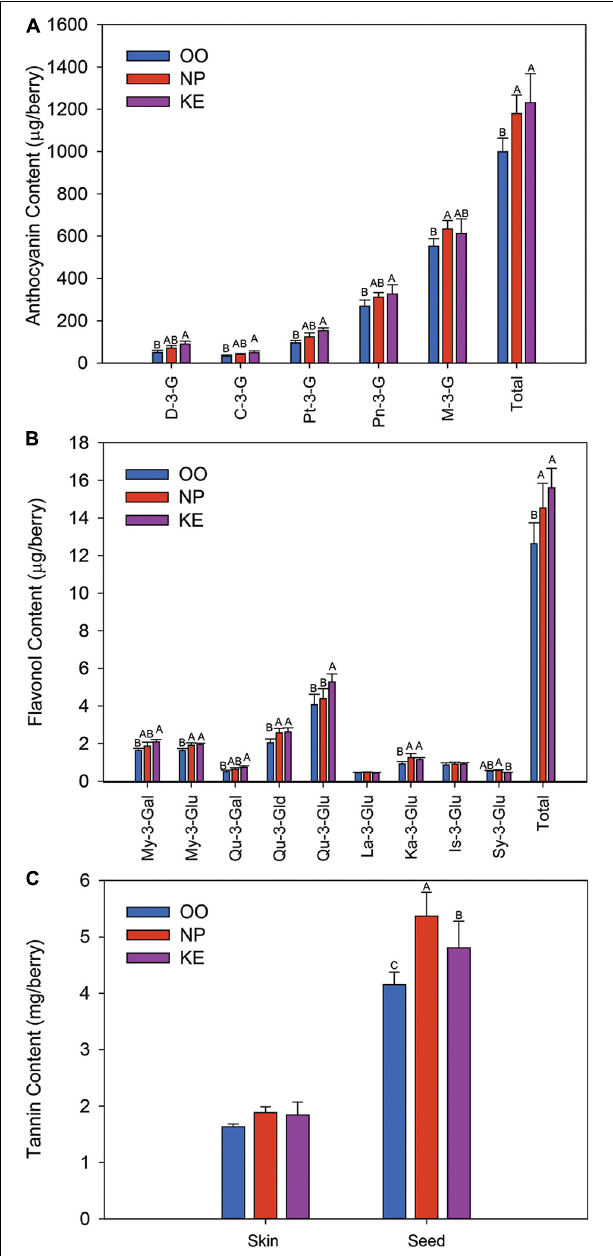
FIGURE 6 | Anthocyanin (A) , flavonol (B) , and tannin (C) content (amount per berry) of Pinot Noir grapes from three sub-regions of the OV (OO, blue; NP, red; and KE, purple). D-3-G, delphinidin-3-glucoside; C-3-G, cyanidin-3-glucoside; Pt-3-G, petunidin-3-glucoside; Pn-3-G, peonidin-3-glucoside; M-3-G, malvidin-3-glucoside for anthocyanins (A) ; and My-3-Gal, myricetin-3-galactoside; My-3-Glu, myricetin-3-glucoside; Qu-3-Gal, quercetin-3-galactoside; Qu-3-Gld, quercetin-3-glucuronide; Qu-3-Glu, quercetin-3-glucoside; La-3-Glu, laricitrin-3-glucoside; Ka-3-Glu, kaempferol-3-glucoside; Is-3-Glu, isorahamnetin-3-glucoside; Sy-3-Glu, syringetin-3-glucoside for flavonols (B) . Error bars indicate the standard error within each sub-region. An ANOVA was performed to test the effect of the sub-regions with vineyards considered as nested factors within sub-regions. Different letters indicate significant differences ( p < 0.05) between sub-regions according to a Tukey’s HSD